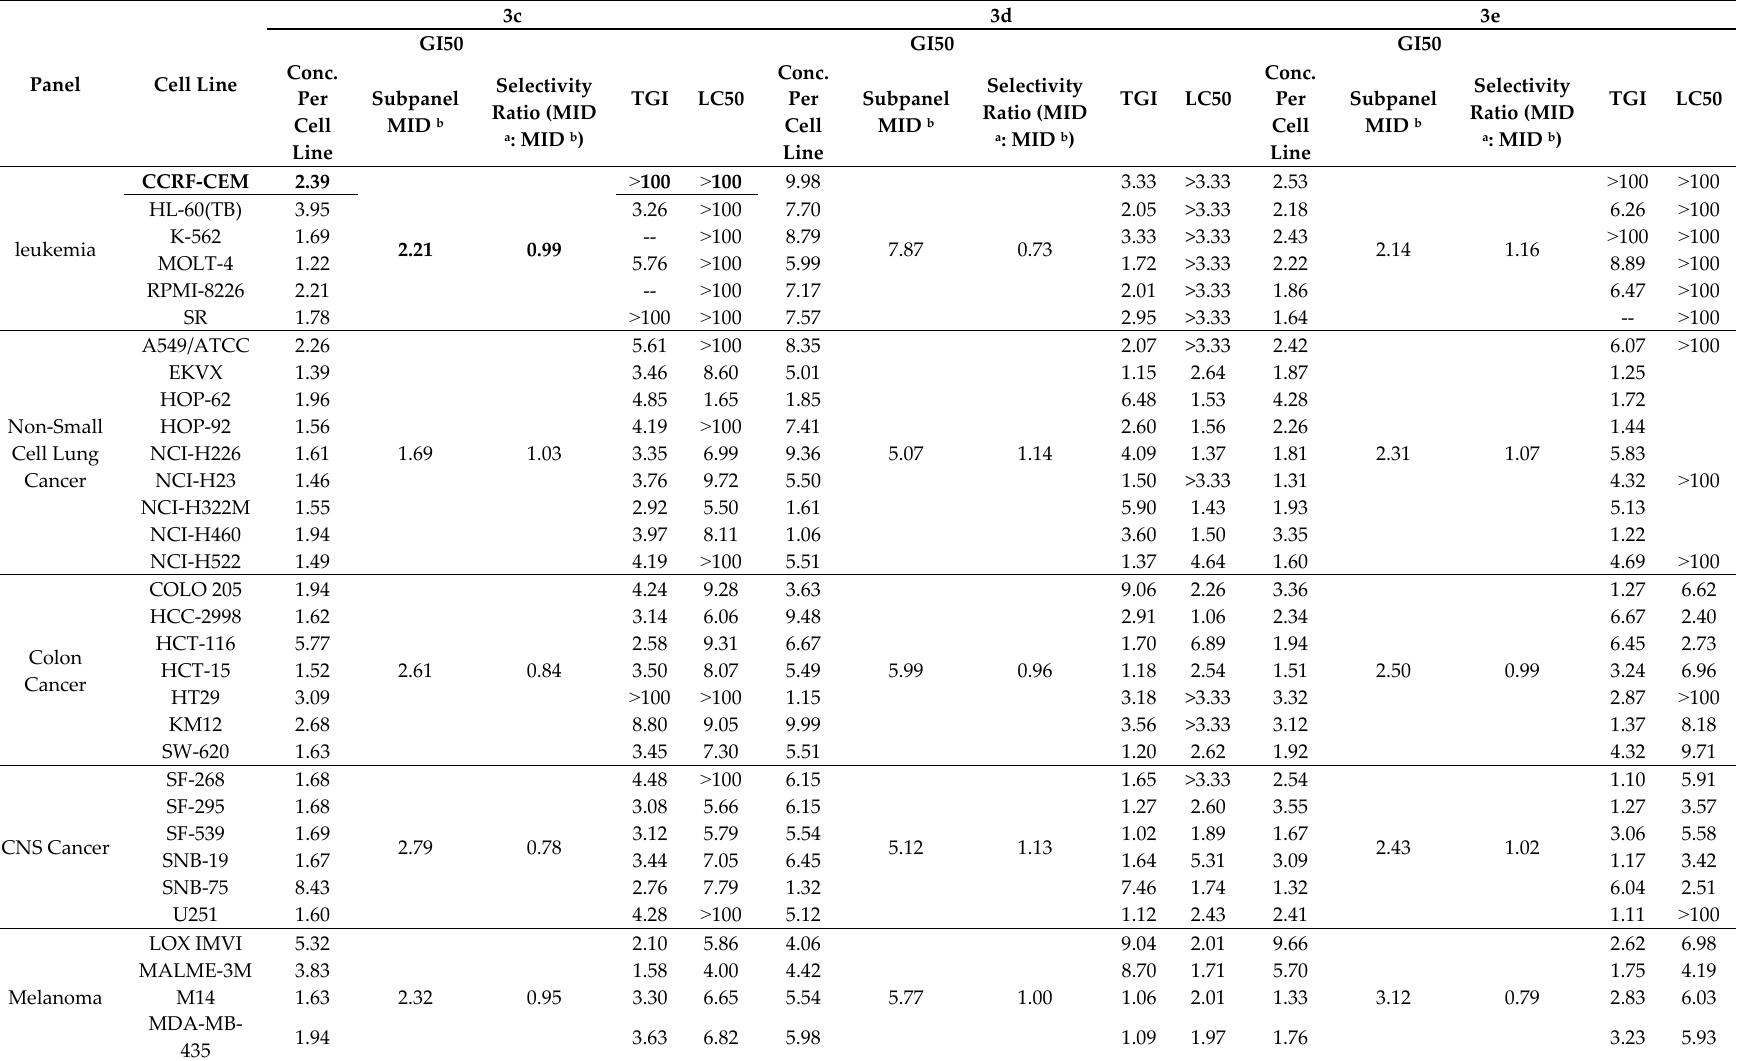
Table 2. Results of in vitro five-doses testing of nine human cancer types and selectivity for compounds 3c, 3d, and 3e